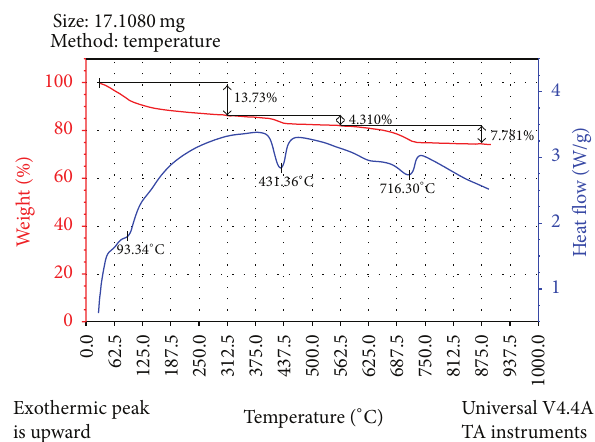
Figure 12: The results of XRD test. Note: Aft: Ettringite; CH: Ca(OH) 2 ; Si: SiO 2 ; C: CaCO 3 ; CS: C 2 S; JZ: control specimen; Z20%: specimen with 20 wt% CWBP; FH30% and FH40%: specimens with 30 wt% and 40 wt% CWCPM, respectively.